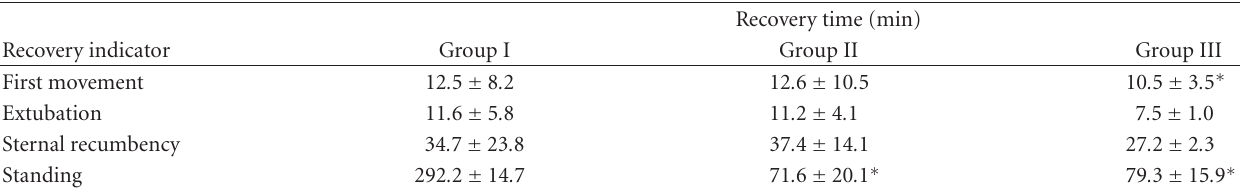
Table 7: Recovery times in pigs anesthetized with sevoflurane, fentanyl, and vecuronium and undergoing aortic cross-clamping through laparotomy (Group I) or laparoscopy with (Group II) or without aortic cross-clamping (Group